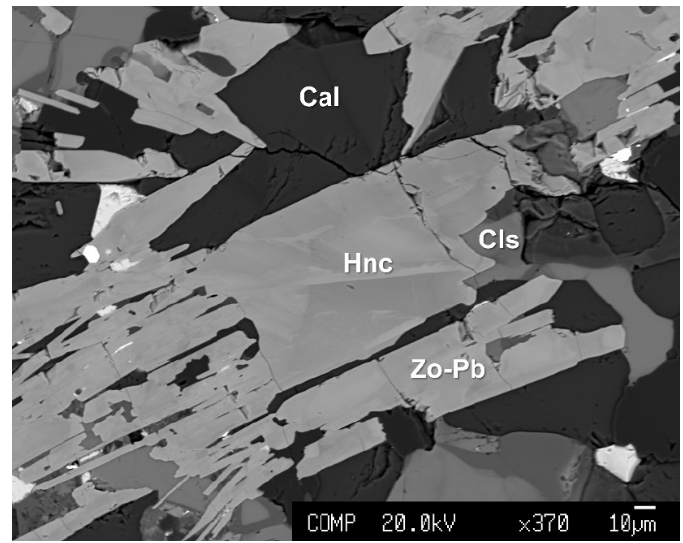
Figure 2. Backscattered electron image of zoisite-(Pb) (Zo-Pb) and associated hancockite (Hnc), with calcite (Cal) and Pb-bearing celsian (Cls). Mineral symbols after [25]. It is mainly related to different Ca/Pb atomic ratios in both zoisite-(Pb) and han- cockite (Figure 3). These two phases can, in addition, be distinguished on the basis of their Al/(Al + Fe tot ) atomic ratio, as indicated above and confirmed by micro-Raman spec- troscopy (see below).